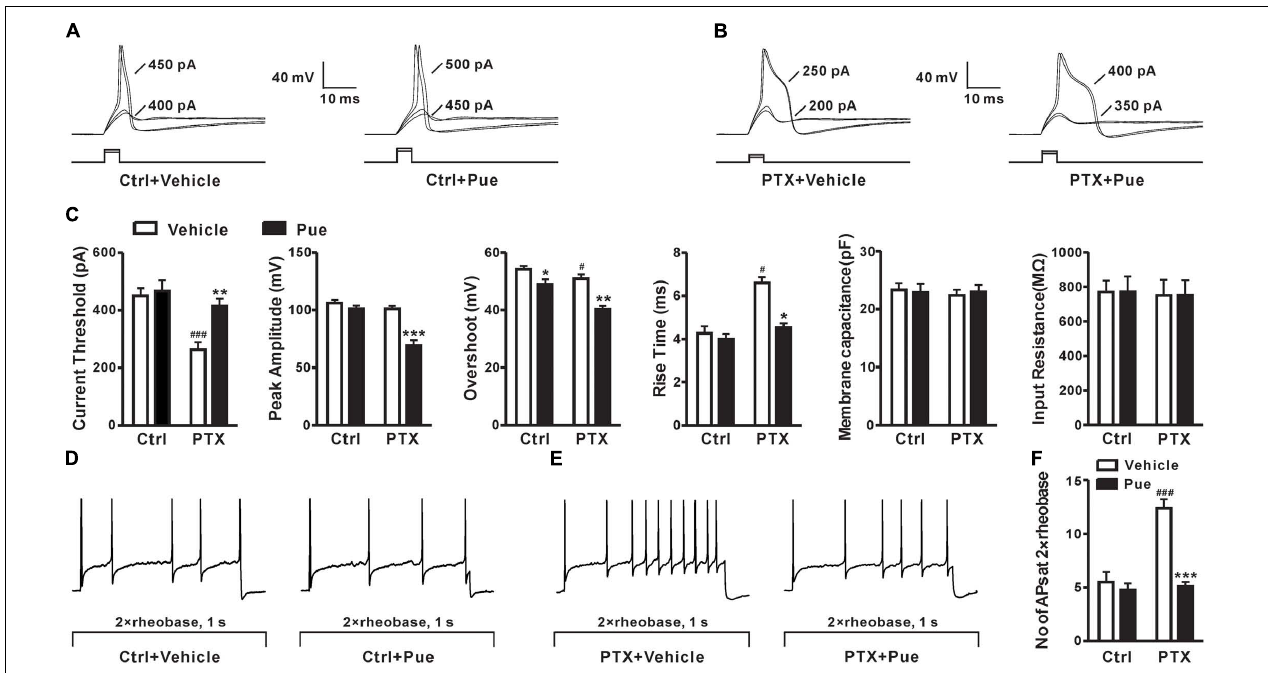
FIGURE 2 | Puerarin reduces paclitaxel-induced hypersensitivity in DRG neurons (Ctrl, control; PTX, paclitaxel; Pue, puerarin). (A,B) The representative traces show the thresholds of action potentials evoked by current injections to DRG neurons from control rats (A) and paclitaxel rats (day 10) (B) before and 15 min after the application of 5 µ M puerarin. (C) Comparisons of the threshold of action potentials, the peak amplitude, the overshoot, the rise time, the membrane capacitance and the input resistance before and after puerarin treatment. (D,E) The typical traces indicate the action potentials elicited by 2 × rheobase for 1 s in DRG neurons of control rats (D) and paclitaxel rats (day 10) (E) before and after puerarin. (F) The summary data show the comparison of the numbers of action potentials in control and paclitaxel (day 10) rats with or without puerarin. n = 12 neurons in each group. ∗ P < 0.05, ∗∗ P < 0.01, ∗∗∗ P < 0.001 compared to the corresponding vehicle groups; # P < 0.05, ### P < 0.001 compared corresponding to control